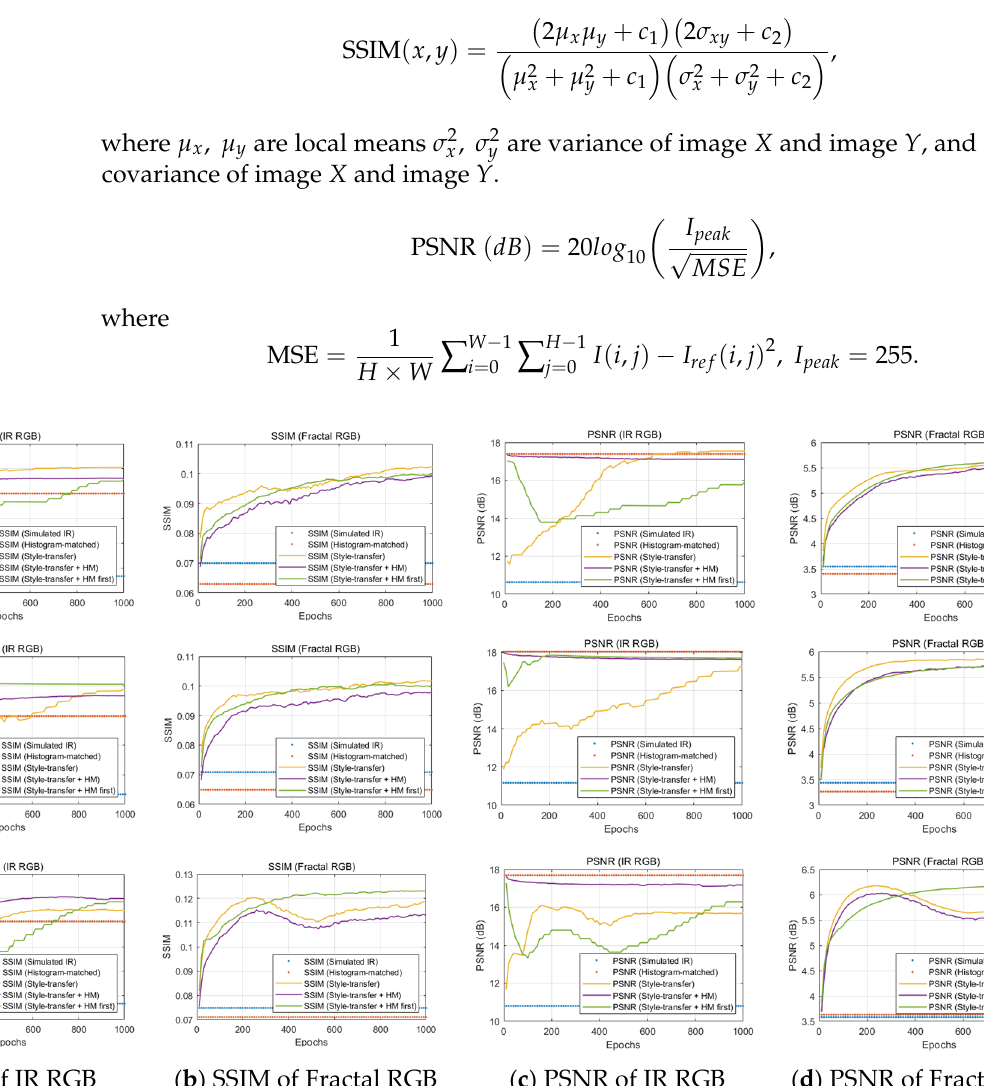
Sensors 2023 , 23 , 422 10 of 14 (HM) IR images; ( d ) Neural style transferred IR images; ( e ) Proposed histogram-matched neural style transferred IR images. For the quantitative evaluation of the results from Figure 5, both SSIM and PSNR changes in epochs were examined. The formulas for SSIM and PSNR follow Equation (13)